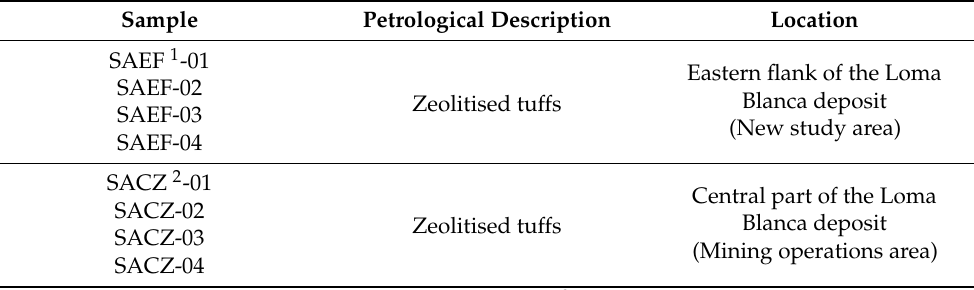
Figure 1. Location map of the research area and sampling points [14]. Table 1. List of analysed samples in this research.